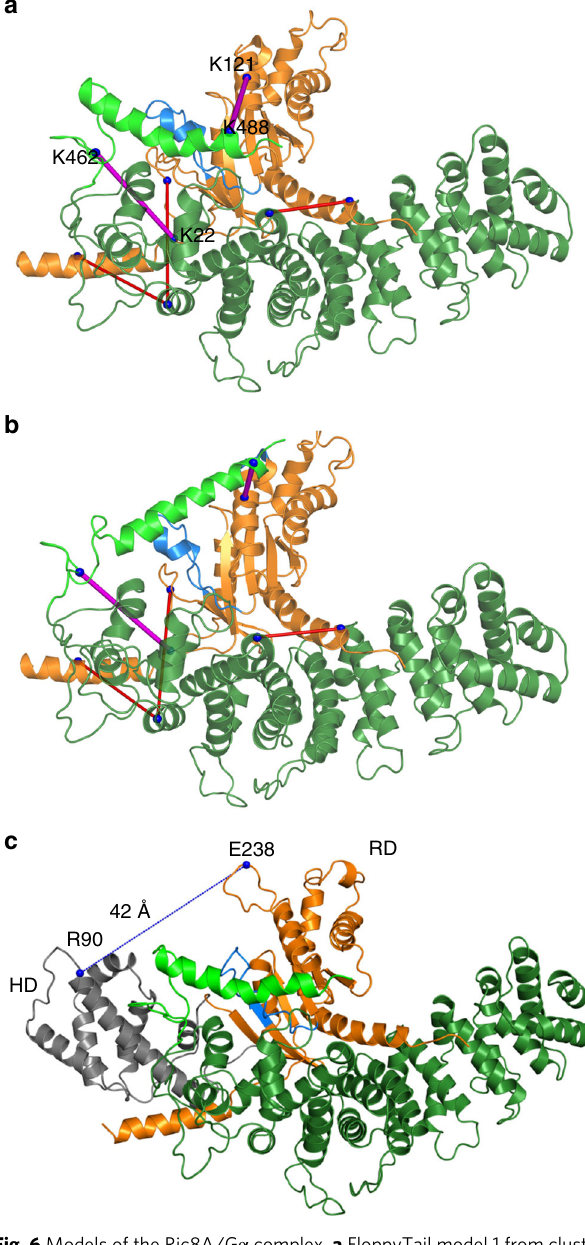
Fig. 6 Models of the Ric8A/G α complex. a FloppyTail model 1 from cluster I of Ric8A1 – 492/ Δ N19-miniG α i models with the addition of 19 N-terminal residues of miniG α i . Ric8A is shown in green and Δ N19-miniG α i is shown in orange with the switch II region shown in blue. Distal C-terminal tail residues 455 – 470 extend beyond the C-terminal end of the Ric8A core domain, and the Ric8A 471 – 490 helix (light green) is situated along the switch II region (blue) and the α 3- β 5 loop. Five intermolecular crosslinks between Ric8A1 – 492 and miniG α i were identi fi ed by XL-MS analysis and Protein Prospector 61 . All of the crosslinks satisfy the distance threshold of 30 Å 74 . The crosslink pairs that involve the distal portion of the Ric8A C- terminal tail and that were used in modeling (K488/miniG α i -K122 and K462/miniG α i -K21) are shown in magenta; all other crosslinks are in red. b FloppyTail model 2 from cluster II of Ric8A1 – 492/ Δ N19-miniG α i models. The Ric8A 471 – 490 helix (isolated light green helix) hangs over the switch II region (blue) and points towards the switch III region. The crosslinks are shown as in ( a ). c Model of the Ric8A1 – 492/G α i complex with a 42-Å separation of the α -helical domain (HD, gray) and Ras-like domain (RD, orange) of G α